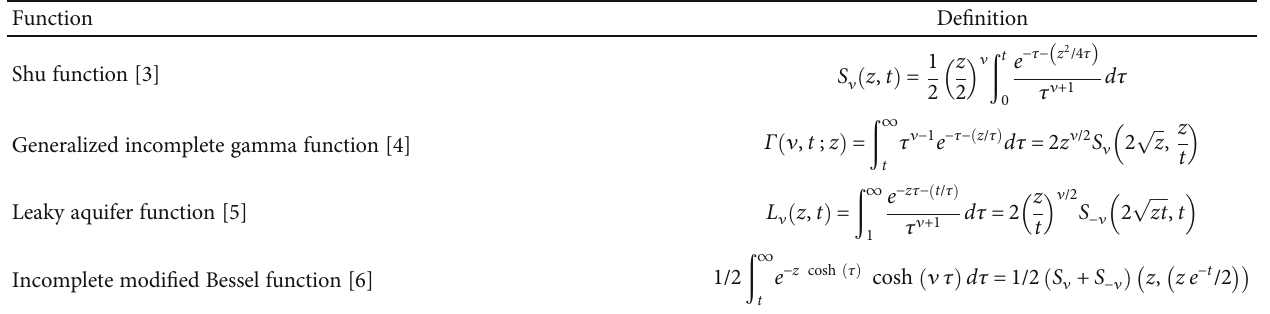
Table 1: Various distinct incomplete versions of the Macdonald